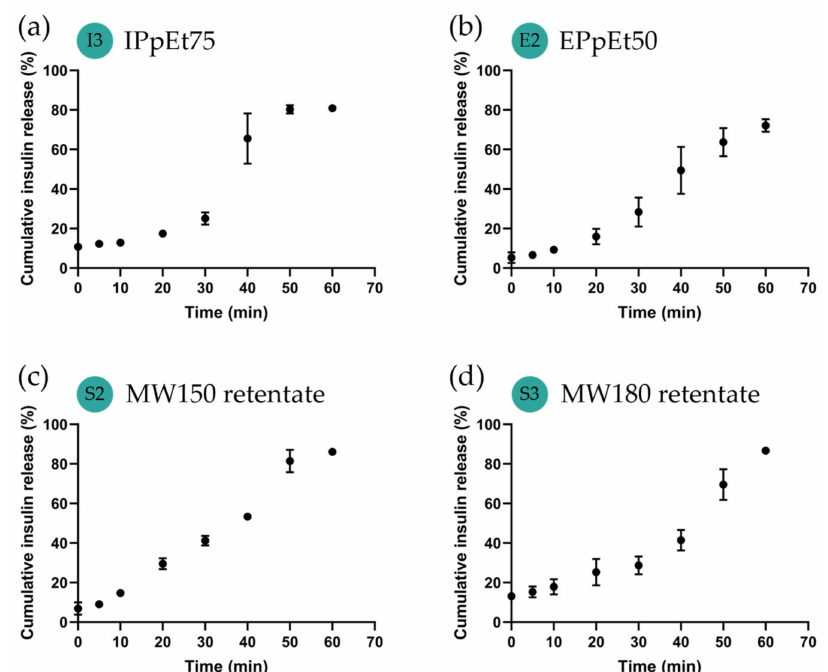
Figure 6. Insulin in vitro release from microparticles based on ( a ) IPpEt75, ( b ) EPpEt50; ( c ) MW150 retentate; ( d ) MW180 retentate. Insulin was quantified using HPLC. Data correspond to the mean ± SEM of at least two independent